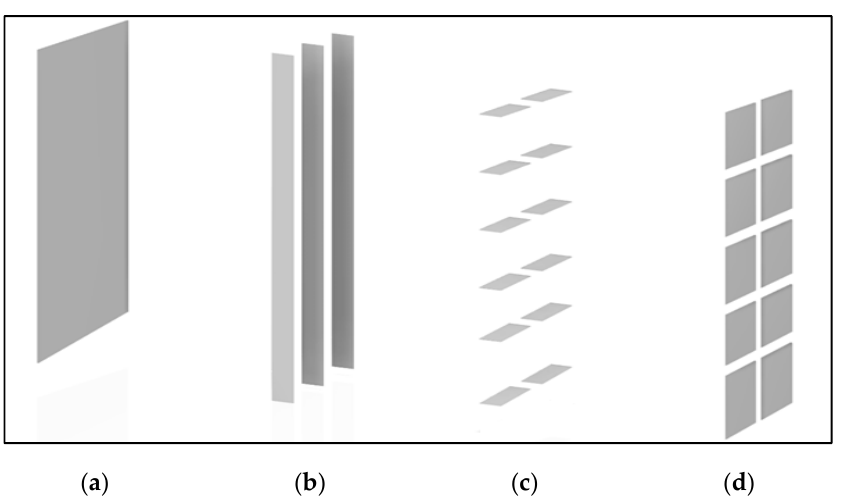
Figure 15. Single panel: ( a ) internal panel; ( b ) vertical stiffening; ( c ) horizontal stiffening; ( d ) external panels.